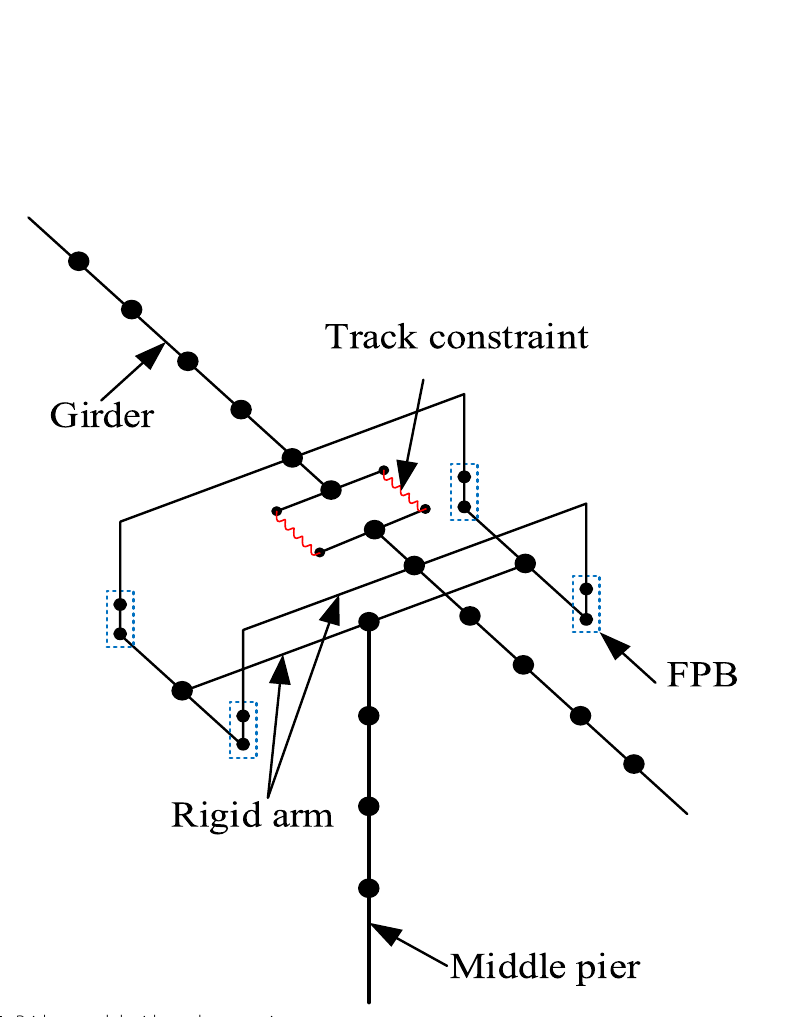
Fig. 11 Bridge model with track